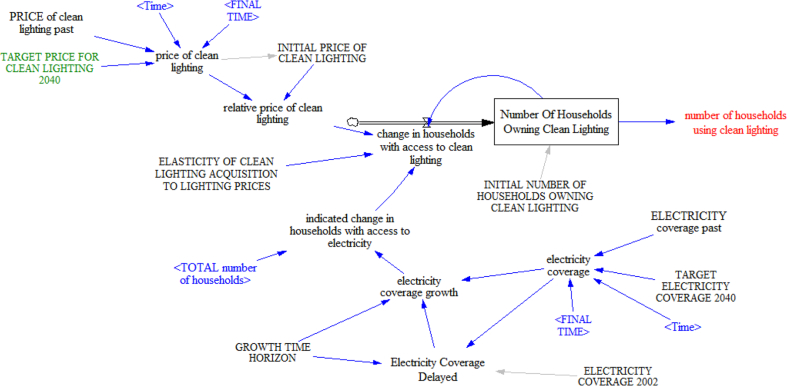
Formulation of number of households using clean lighting.